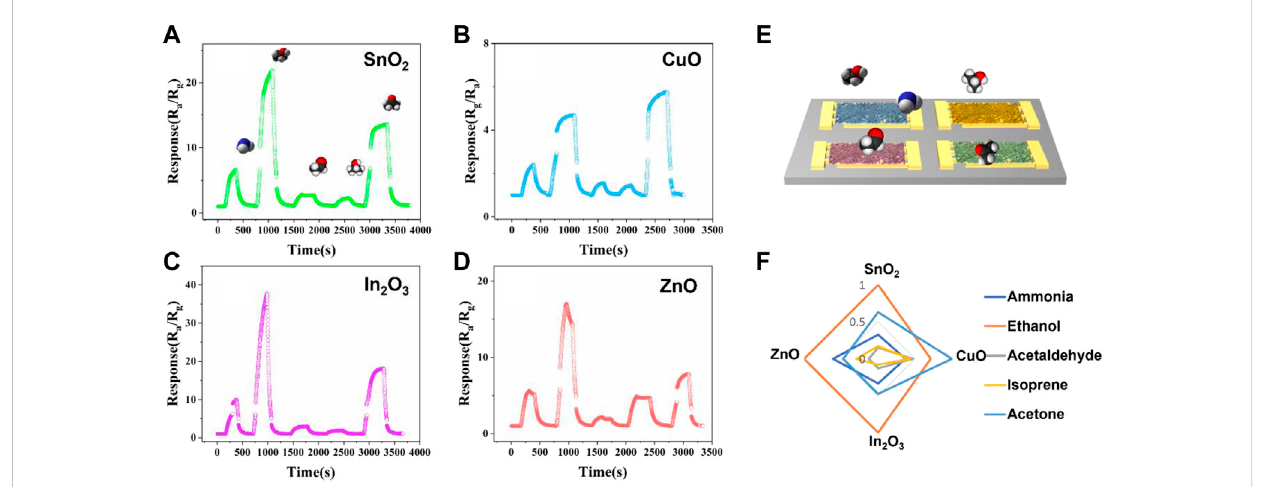
FIGURE 4 Sensingperformanceofthefabricatedfourtypesofnano fi bers (A) SnO 2 , (B) CuO, (C) In 2 O 3 and (D) ZnOMOSgassensorarrayto fi vedifferenttarget gases (from leftto right:20 ppmsamples ofammonia, ethanol, acetaldehyde, isoprene and acetonewereintroduced inseries). (E) Diagram of fabricated